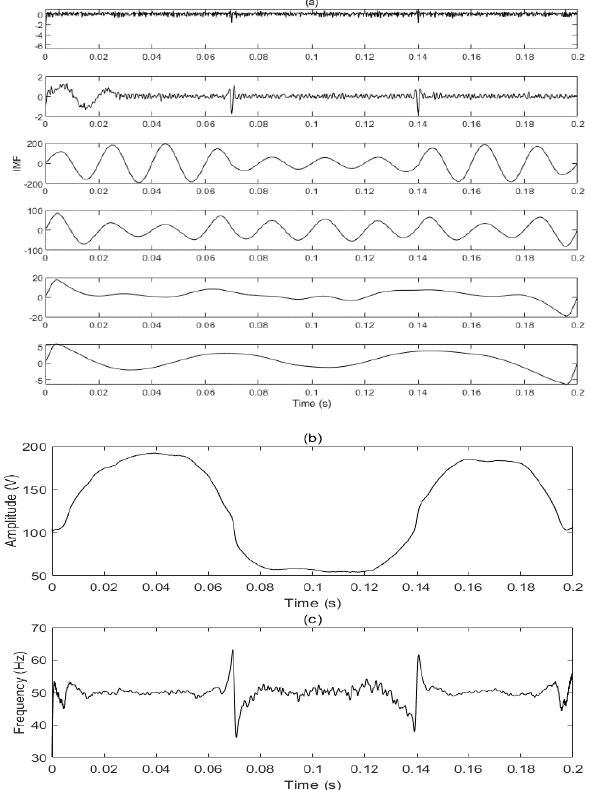
Figure 16. Voltage sag IMF components ( a ), amplitude ( b ), and frequency ( c ).